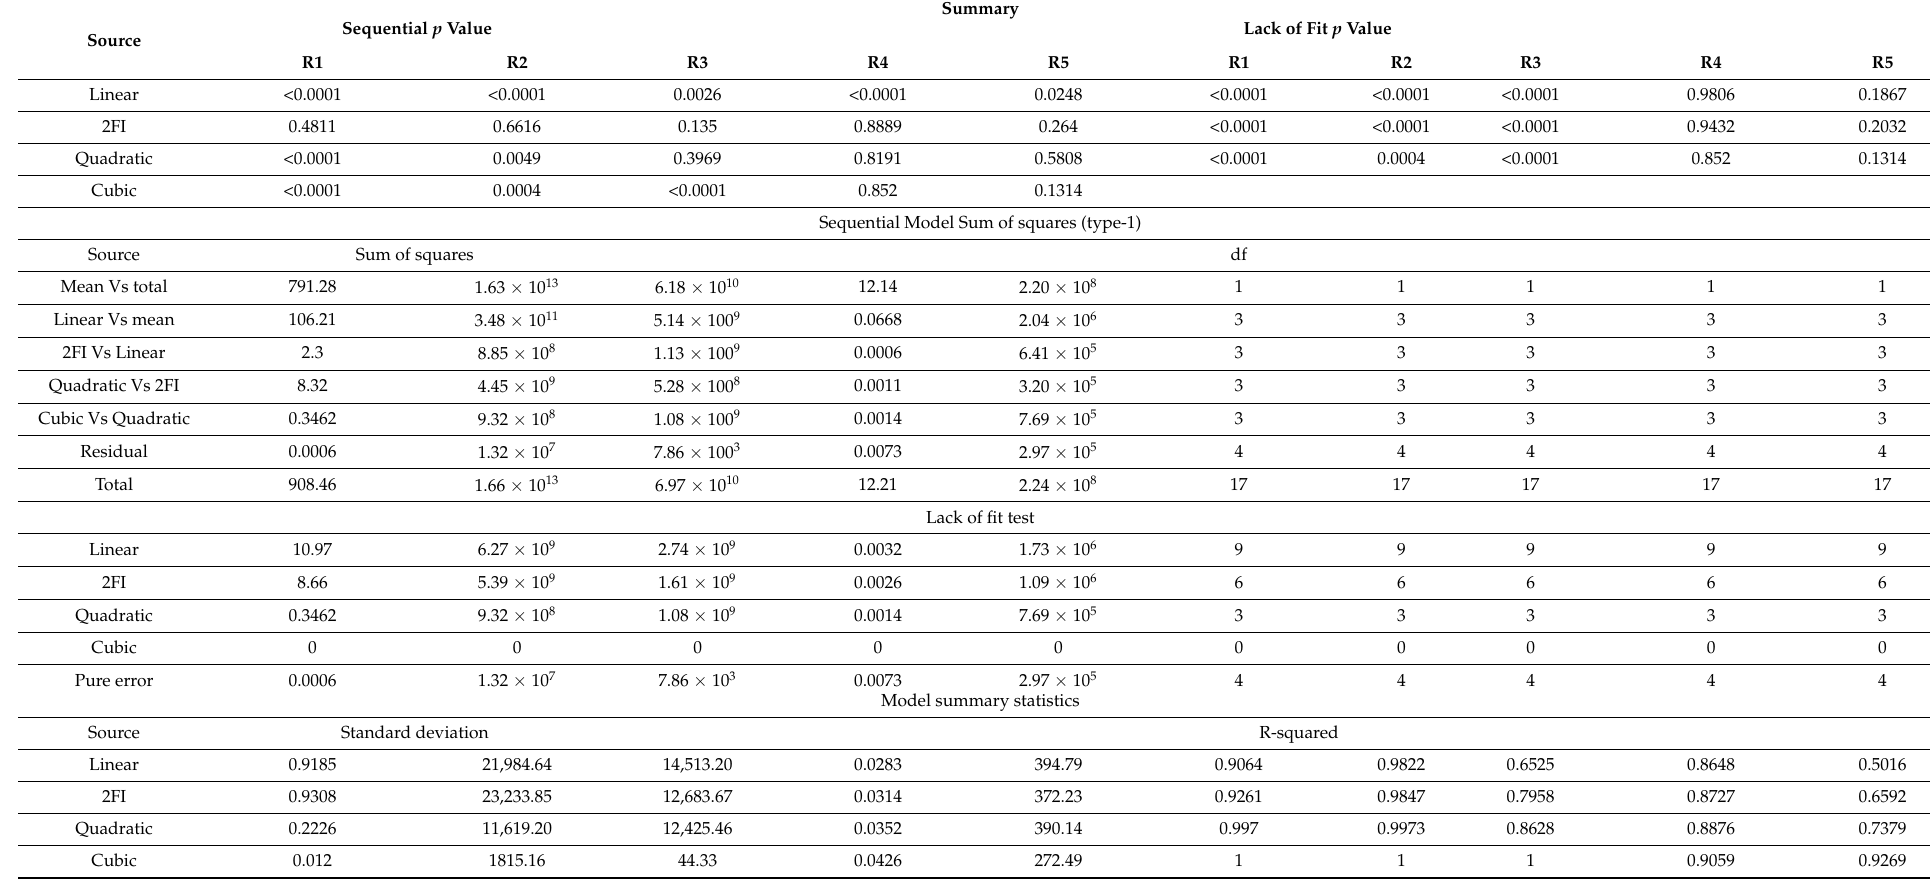
Table 3. The results of ANOVA for multiple regression